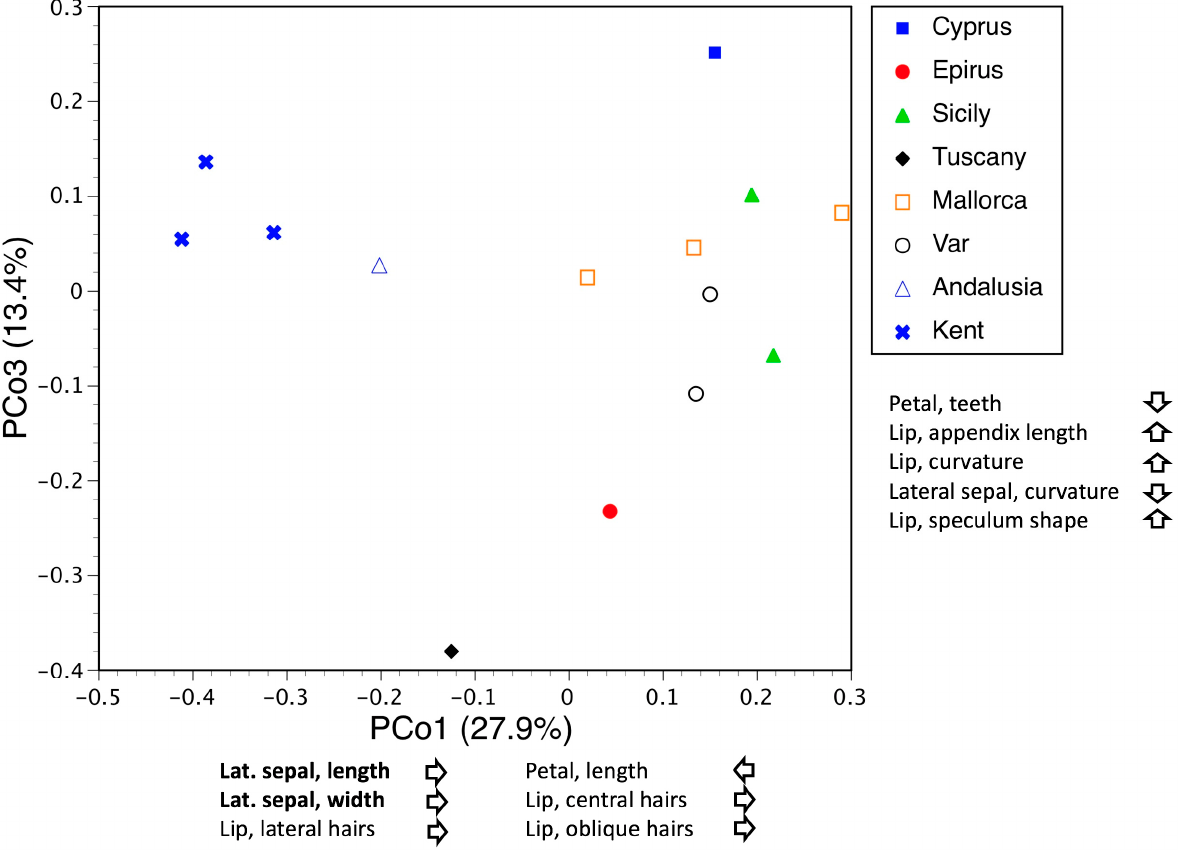
Figure 14. Plot of principal coordinates 1 and 3 for the macrospecies Apifera, labelled according to eight regions of origin: 15 individuals from 15 localities and 49 variable characters. Characters contributing to each coordinate are listed in descending order, with arrows indicating the direction of increase in the value of each character (boldface characters dominate that coordinate).